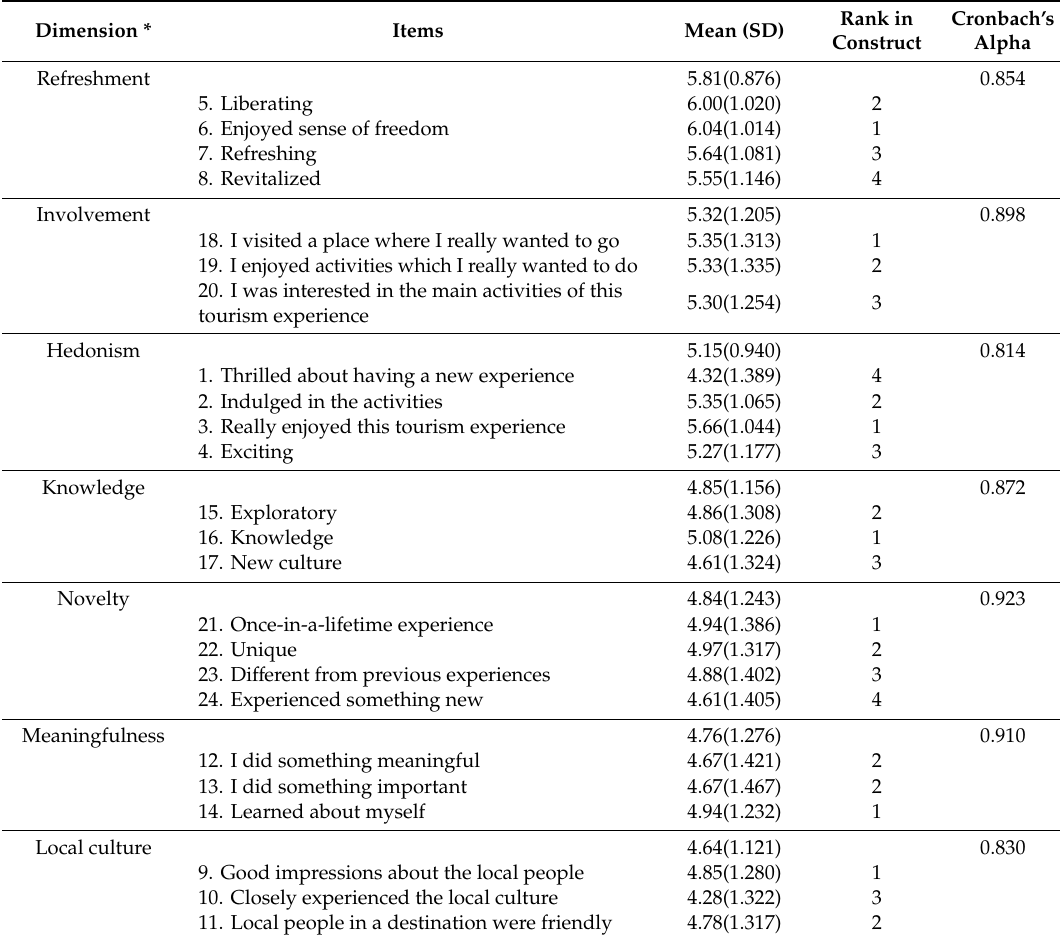
Table 2. Descriptive analysis and reliability of the MTE